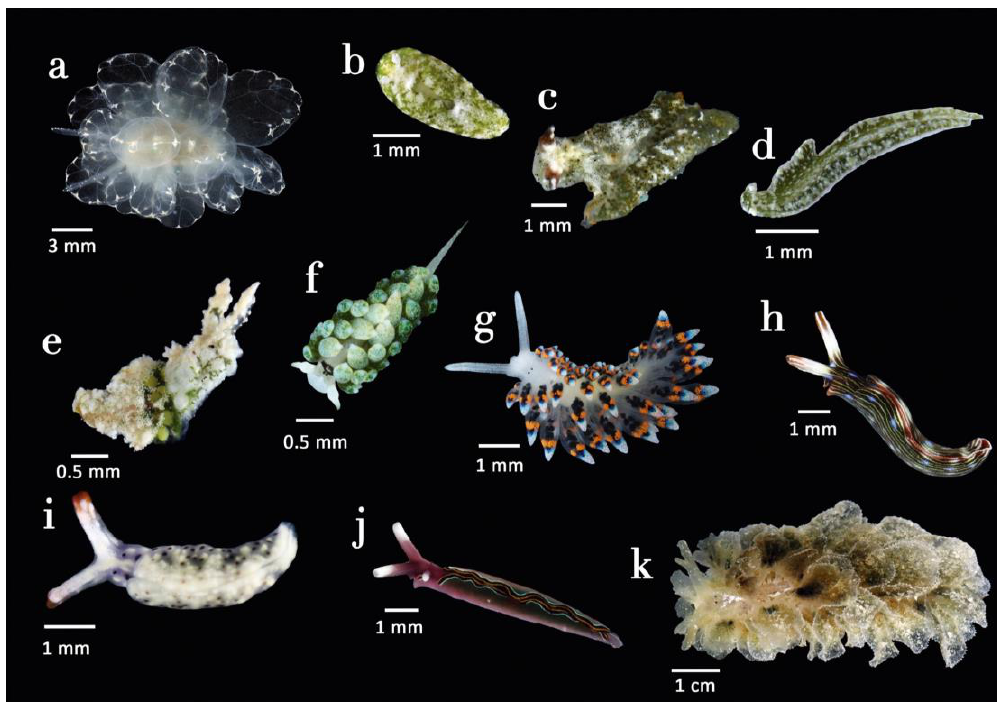
Figure 7. Sacoglossa: ( a ) Cyerce elegans (MCZ:Mala:393754); ( b ) Elysia pusilla (MCZ:Mala:393737); ( c )